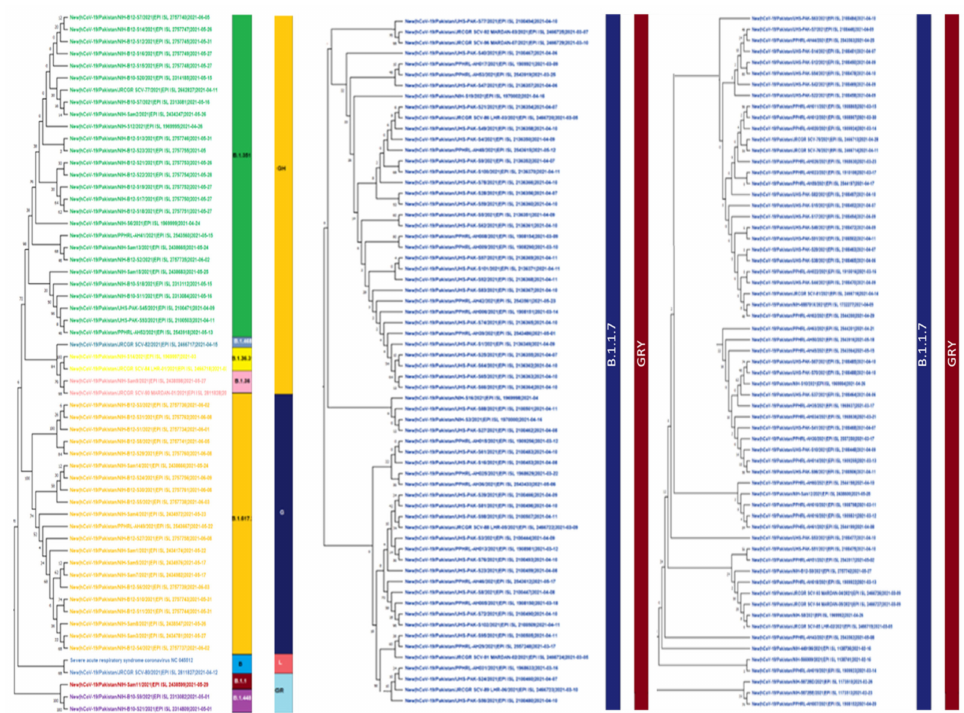
Figure 11. Maximum Likelihood phylogenetic tree of SARS-CoV-2 genome spitted in three columns. This tree is representing 9 lineages (B.1.351, B.1.468, B.1.36.31, B.1.36, B.1.617.2, B, B.1.1, B.1.448,